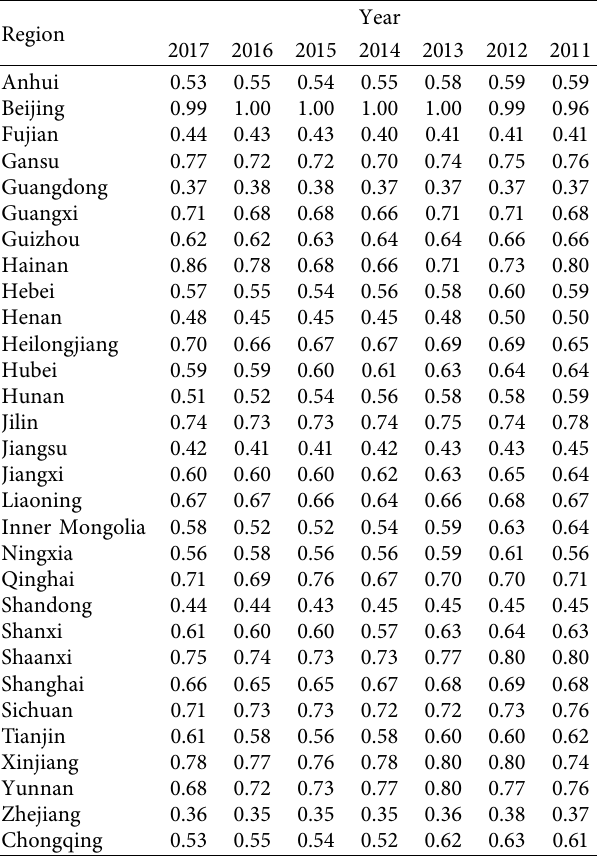
Table 1: Results of innovation collaborative agglomeration. Region